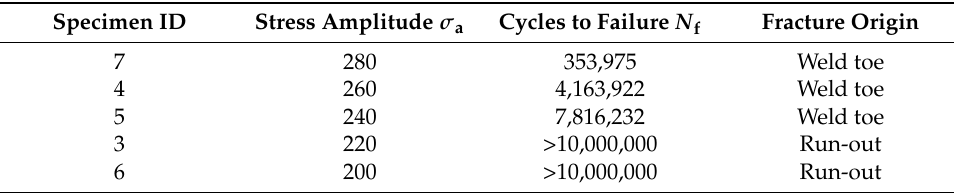
Table A1. Fatigue test results for